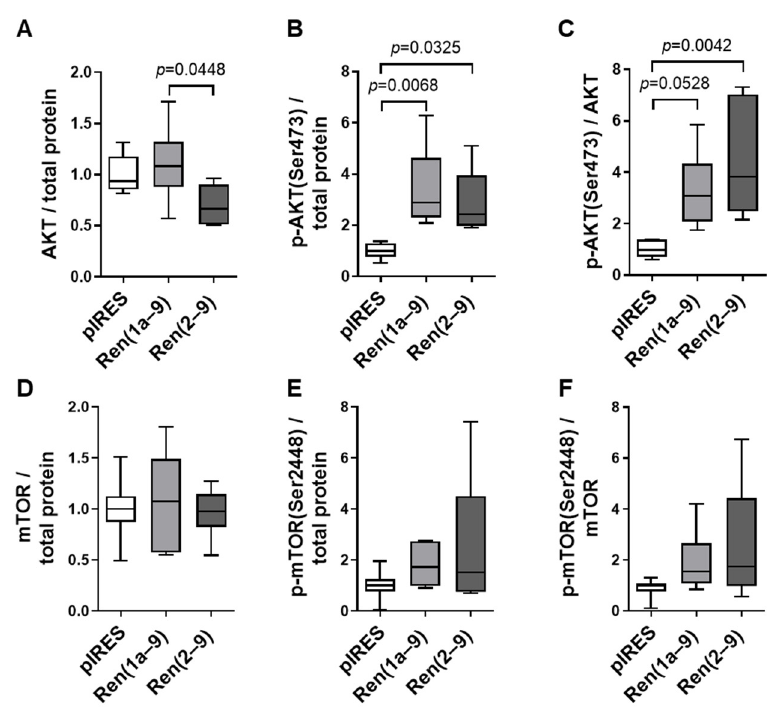
Figure 7. Protein abundances of the kinases AKT and mTOR. The protein levels of total and phos- phorylated ( A – C ) AKT and ( D – F ) mTOR were detected by Western blot analysis of a pIRES control as well as Ren(1a–9) and Ren(2–9)-overexpressing H9c2 cells and normalized to total protein content. Representative western blot images of the protein abundances of the kinases AKT and mTOR are provided in Figure S1. Data of 6 independent experiments per group are shown as box plots, where the top of the box represents the 75th percentile, the bottom of the box represents the 25th percentile, and the line in the middle represents the median. The whiskers represent the highest and lowest values in the dataset. The data were analyzed by one-way ANOVA followed by Tukey’s test. Single p –values < 0.1 vs. pIRES controls or as indicated are given in the figure.